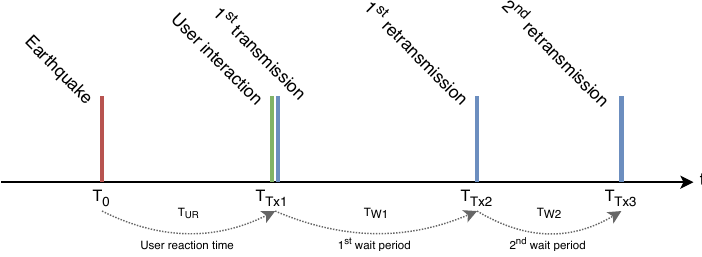
Figure 3. Timing of a user node activity in the aftermath of an